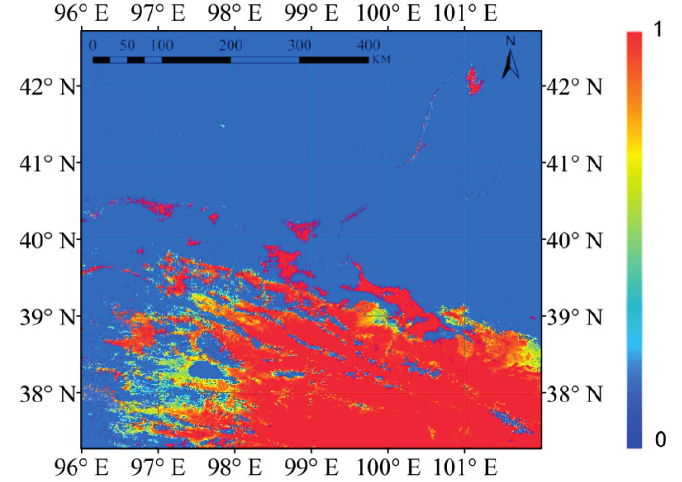
Figure 11. Map of the temporal AC for Heihe River